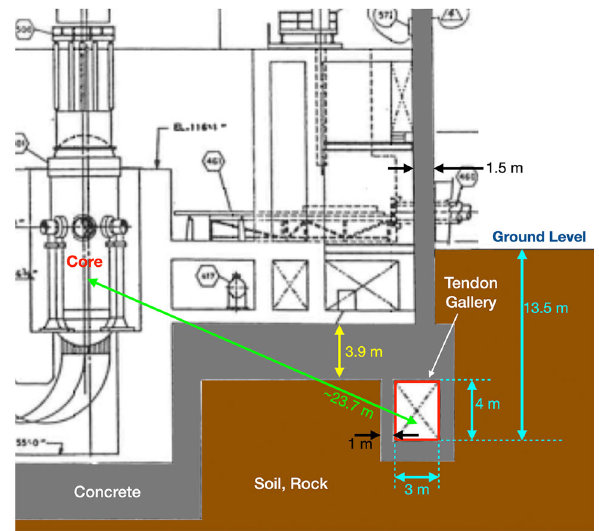
Fig. 1 Schematic view of Hanbit nuclear reactor unit-6. The tendon gallery is 23.7m away from the reactor core that has more than 10m shields of concrete and